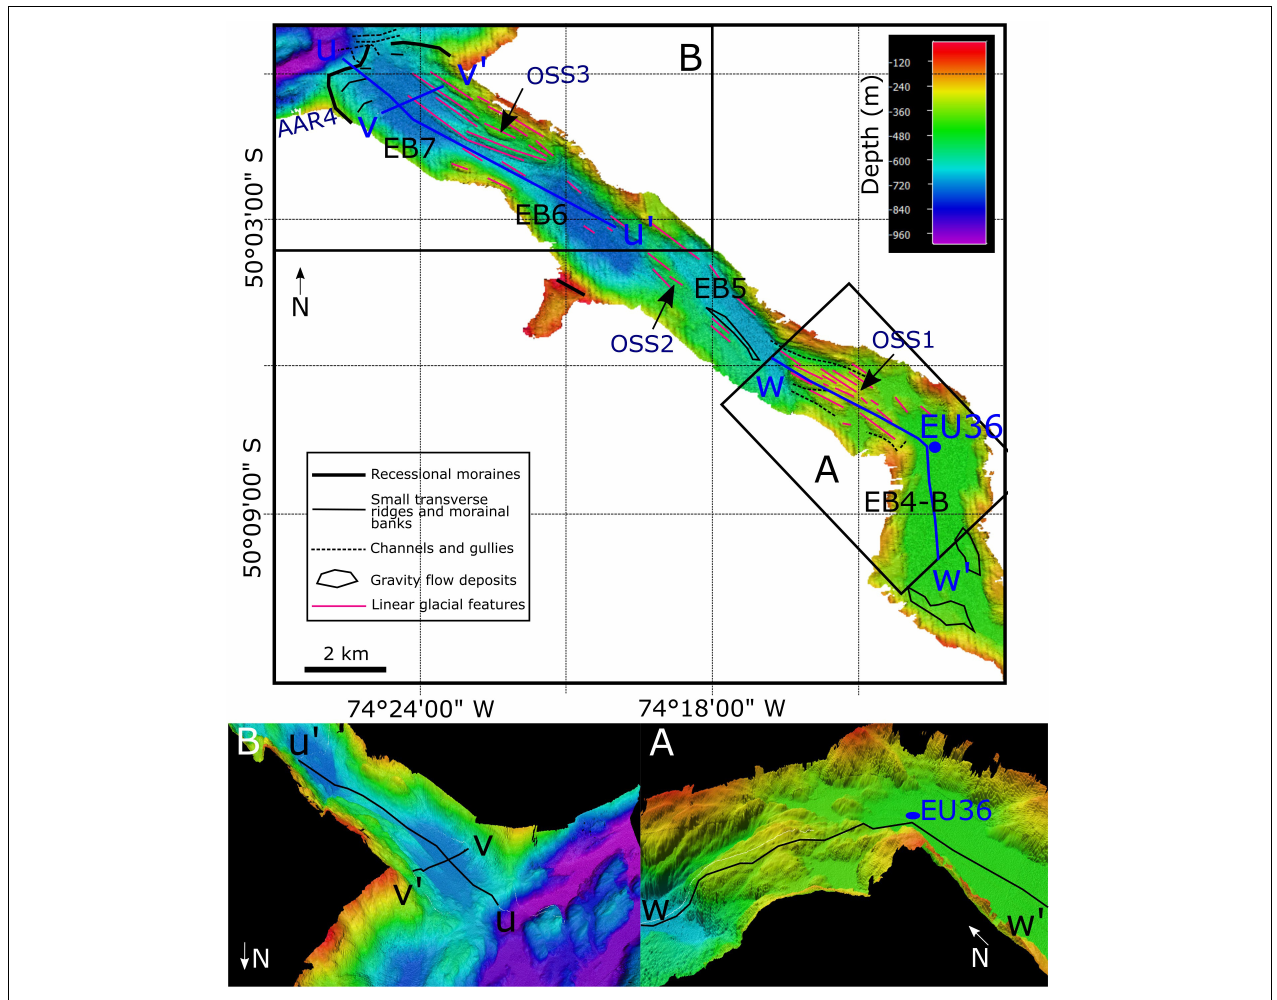
FIGURE 4 | Submarine geomorphology of the outer fjord area from multibeam bathymetry data. Interpretation of landforms are showed. Codes: EB, Europa Basin; AAR, Arcuate Asymmetrical Ridge; OSS, Oblique Streamlined Sills. (A) Eastern subarea and 3D model showing the SBP track for Figure 7 , and location of the EU36 sediment core. (B) Western subarea and 3D model showing the SBP tracks for Figure 7